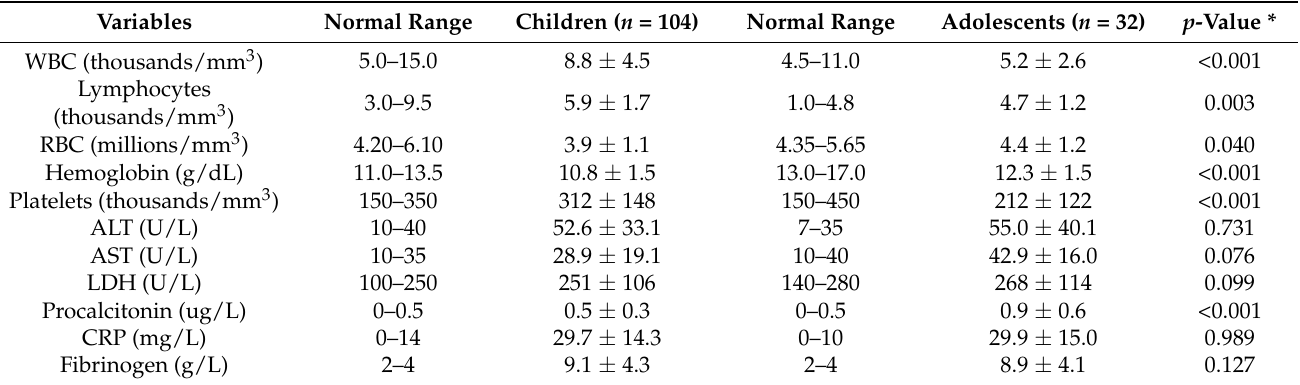
Table 3. Comparison of biological parameters of patients admitted with measles, stratified by duration of hospital stay.